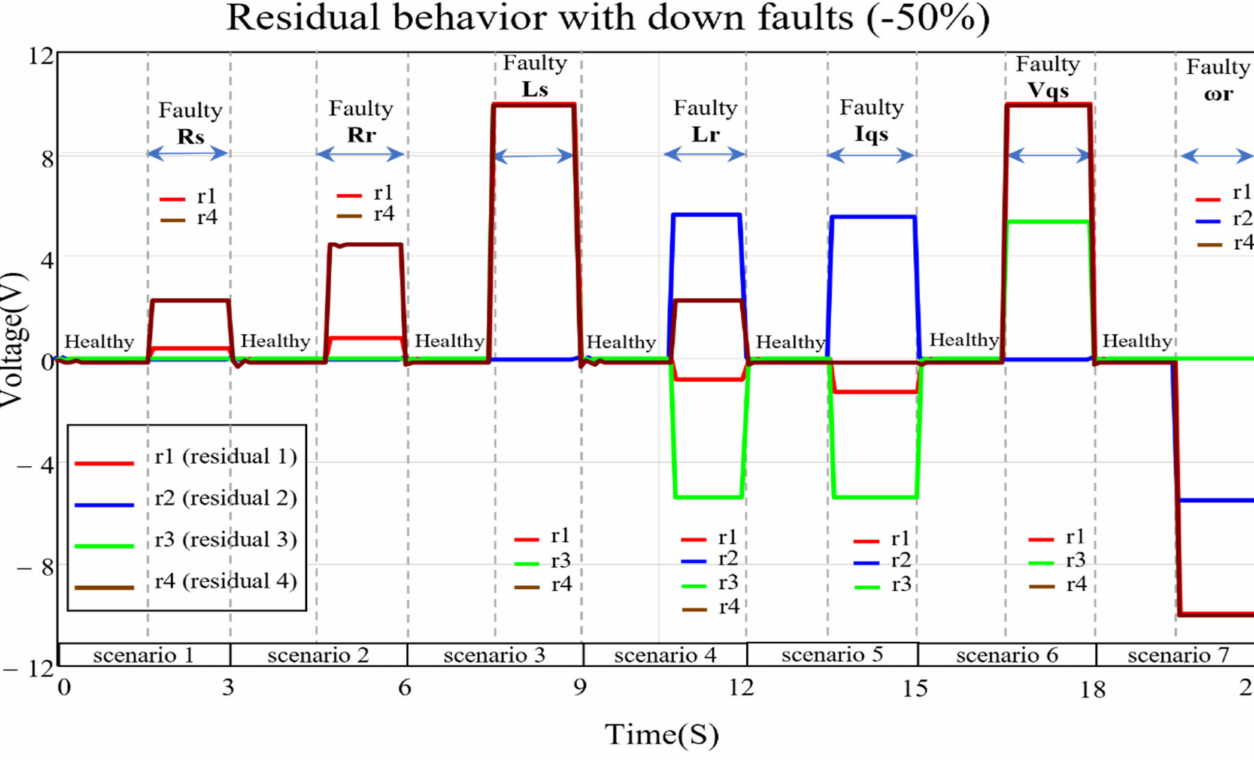
Figure 6. Residual behavior with down parametric variation to − 50% of nominal